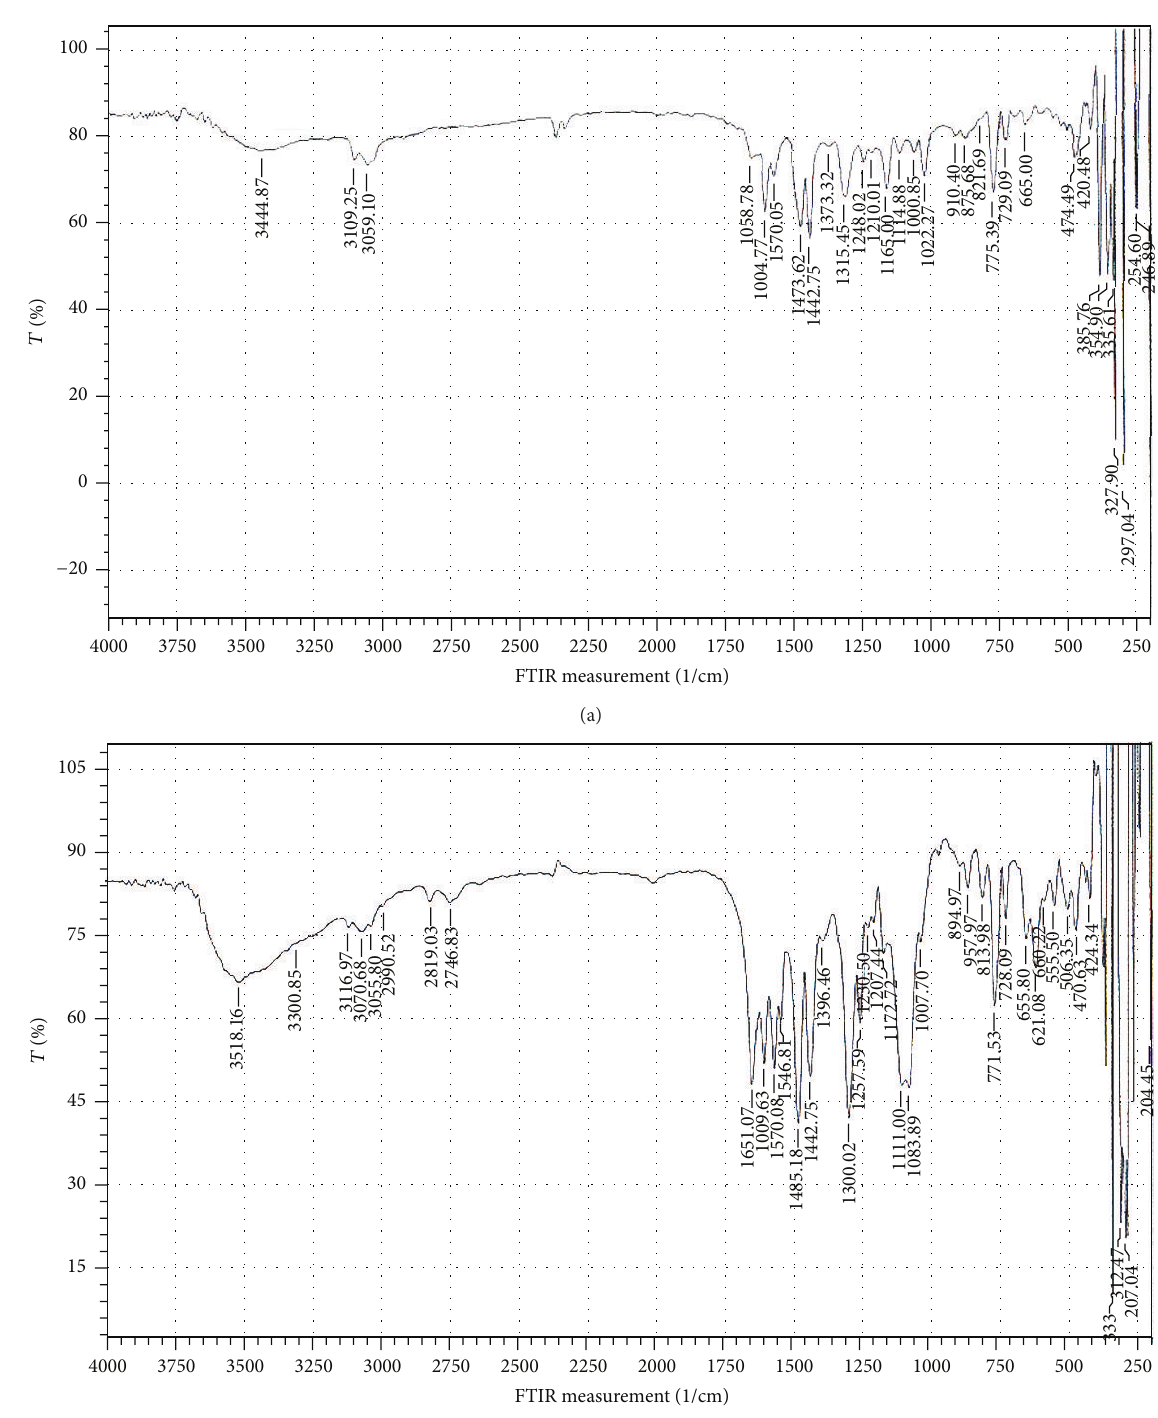
Figure 5: FTIR spectra of (a) C